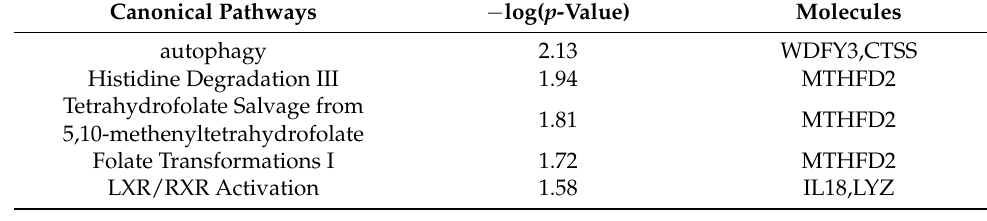
Table 4. Top 5 pathways affected in BAT of Trsp f/f -Ucp1-Cre +/ − mice after acute cold exposure.